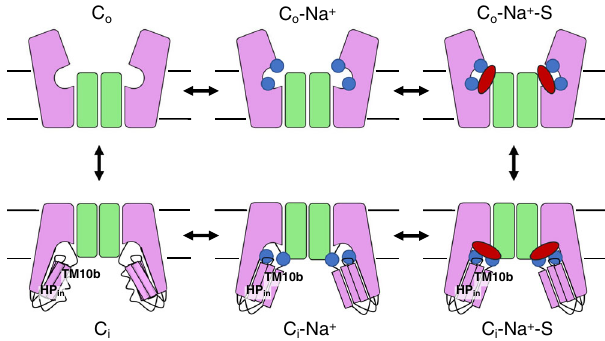
Fig. 6 Schematic model of conformational selection mechanism for sodium — substrate coupling in VcINDY. In the absence of sodium ions, HP in b and TM10b, along with their connecting loops responsible for sodium and substrate binding, are fl exible. From the ensemble of fl exible structures, the binding of sodium ions (blue circles) selects a conformation with a proper binding site for the substrate, allowing its binding (red oval). The scaffold and transport domains in each protomer are colored as green and pink, respectively. Only the Na1 and Na2 sites are illustrated. Transport domain movements in the two protomers are shown as symmetric for simplicity but are functionally